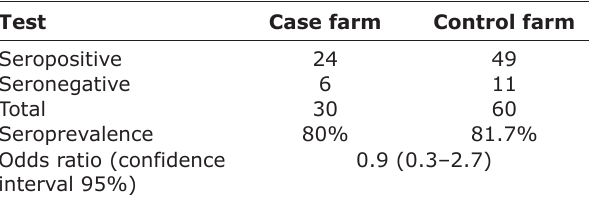
Table-4: Association between seroprevalence and abortion at the individual level. Test Cows from case